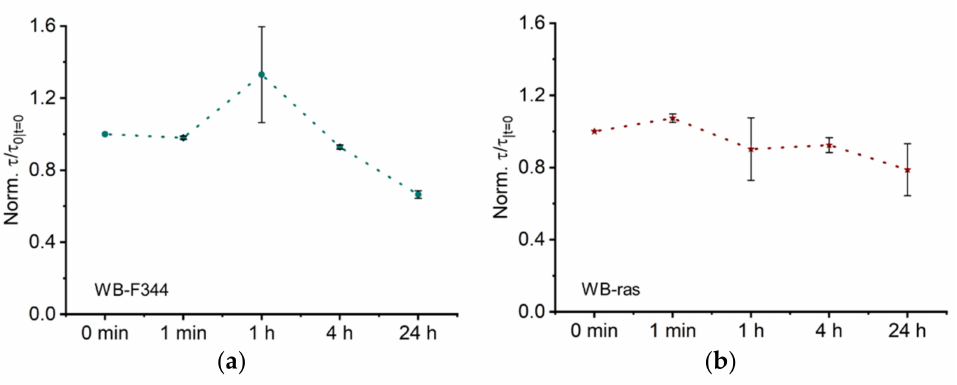
Figure 6. Trends in Cole parameters, characteristic time constant τ , over time following CAP treatment for two cell monolayers, WB-F344 ( a ) and WB-ras ( b